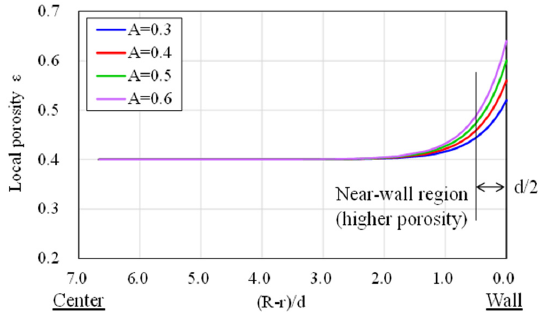
Figure 7. Calculated radial porosity distribution with different A values.